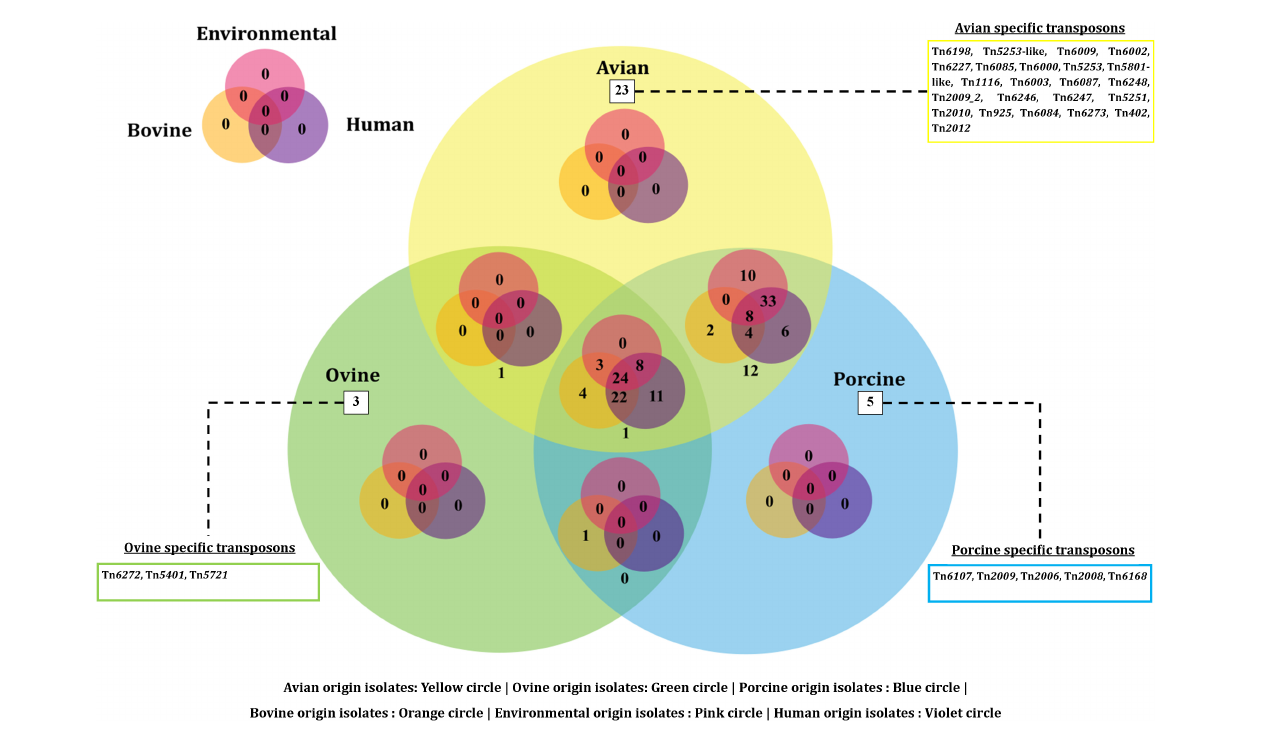
FIGURE6 Venn diagram depicting the categorical distribution of various transposon types among E. fergusonii